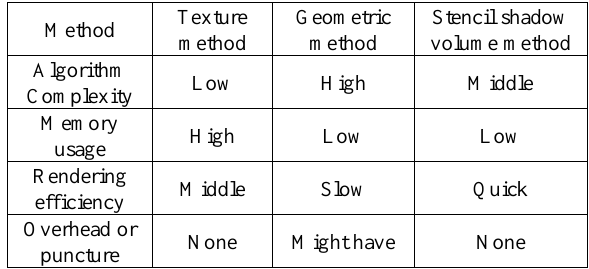
Table 2. Terrain-draped Vector Rendering